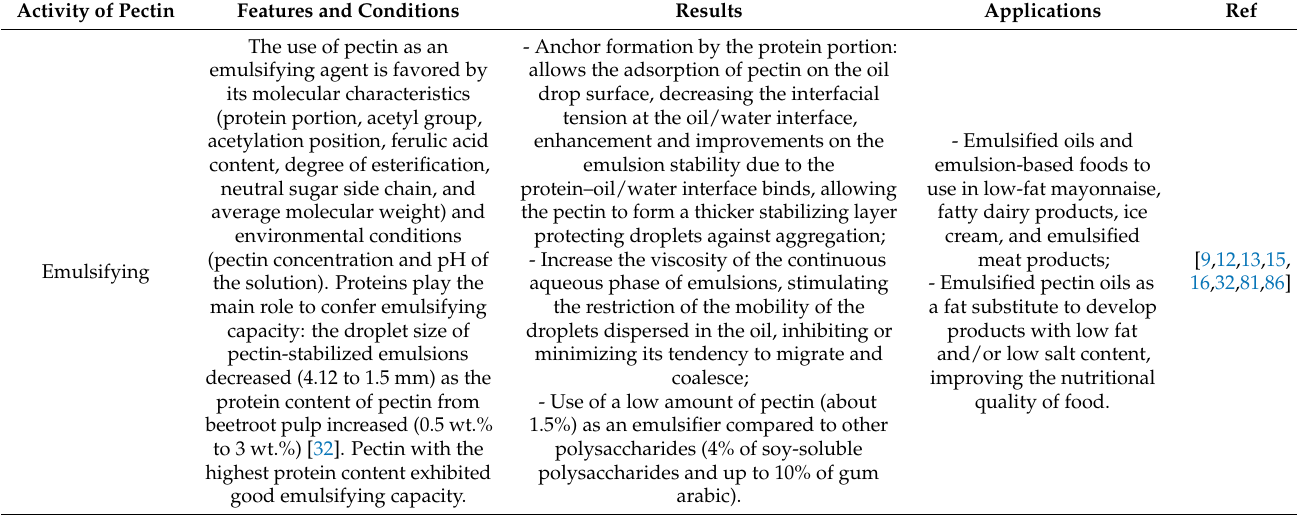
Table 2. Information on the emulsifying activity of